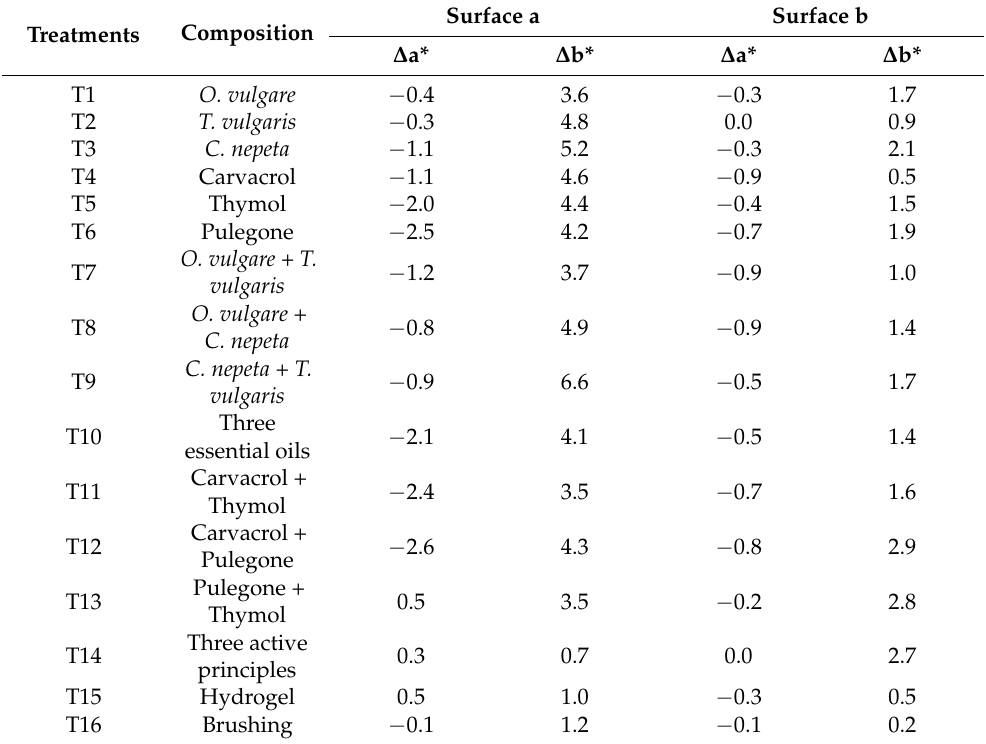
Table 3. Variations in the green-red ( ∆ a*) and blue-yellow ( ∆ b*) chromatic components, calculated between the uncolonized granite and the values from Surface a and Surface b after the cleaning procedures (t 1